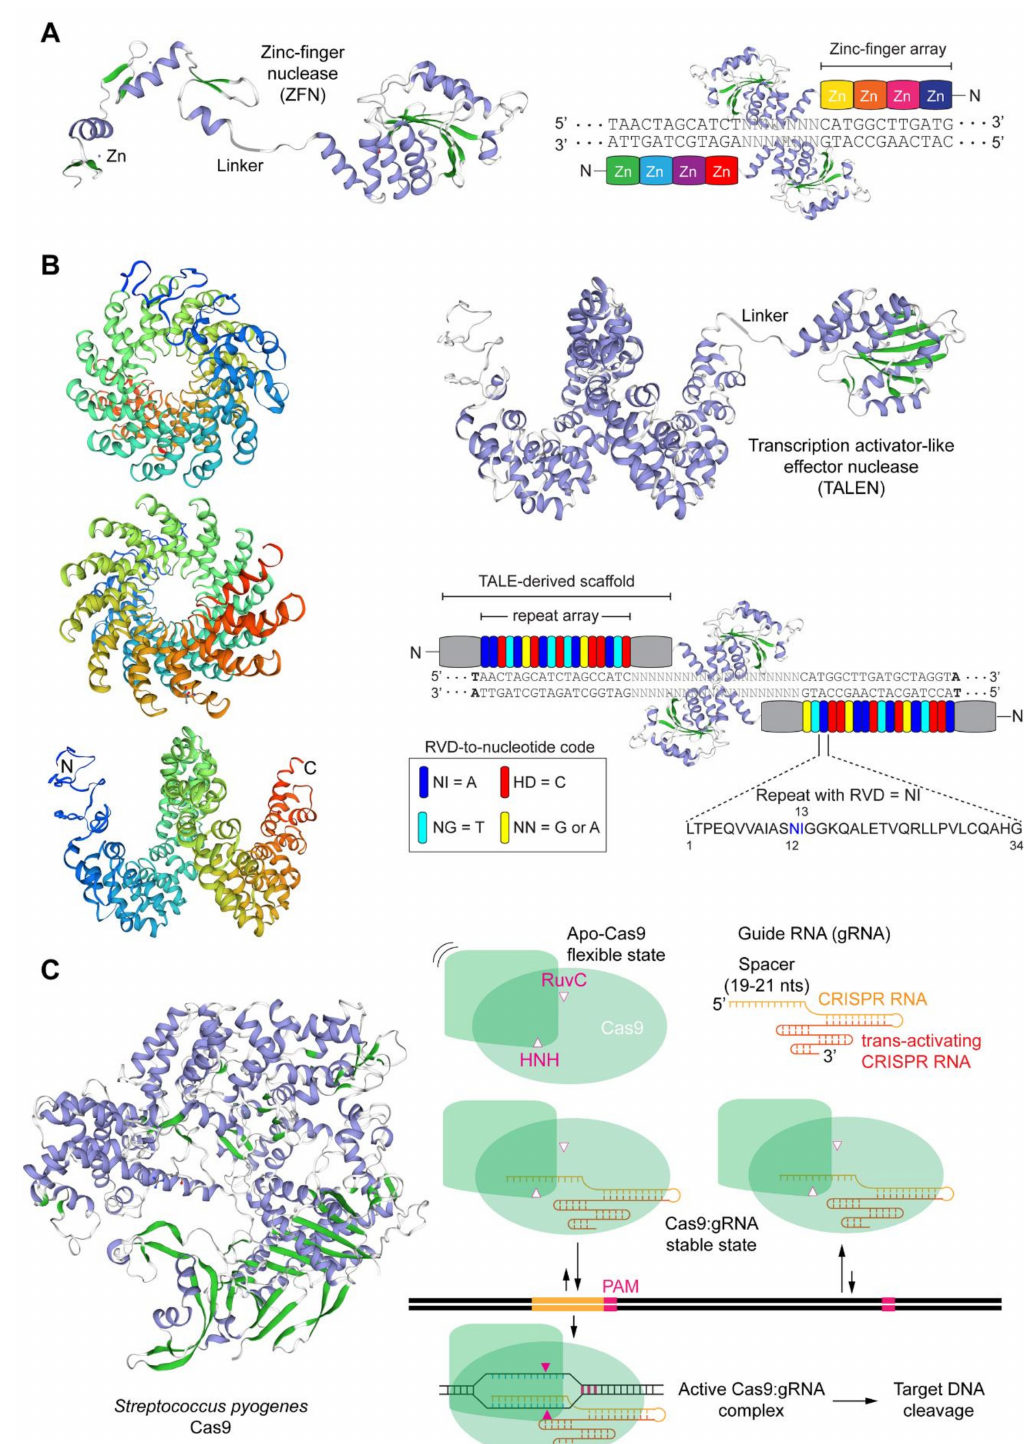
Figure 1. Schematics of the main programmable nuclease platforms. ( A ) Zinc-finger nucleases (ZFNs). ZFNs are chimeric modular DNA-binding proteins consisting of the FokI nuclease domain fused through a flexible linker to an array of 3–6 artificial Cys 2 -His 2 zinc-finger motifs. Each zinc-finger